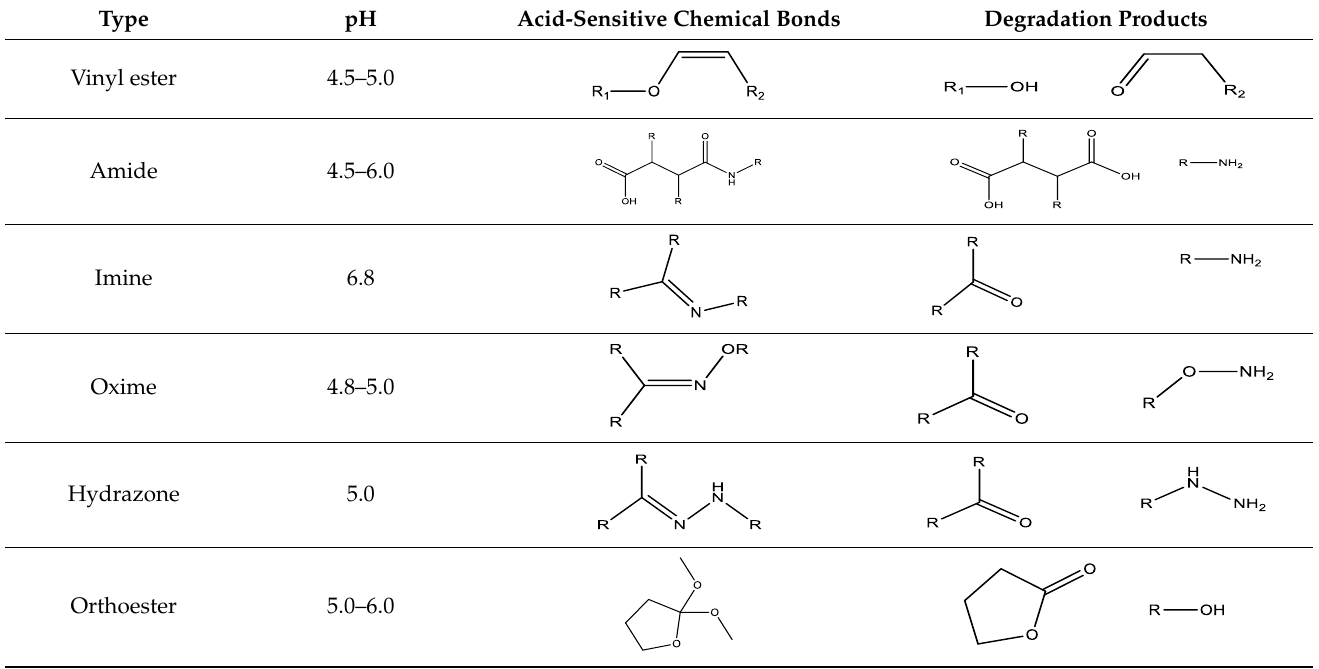
Table 2. Selected examples of pH-sensitive chemical bonds and their degradation products [58].